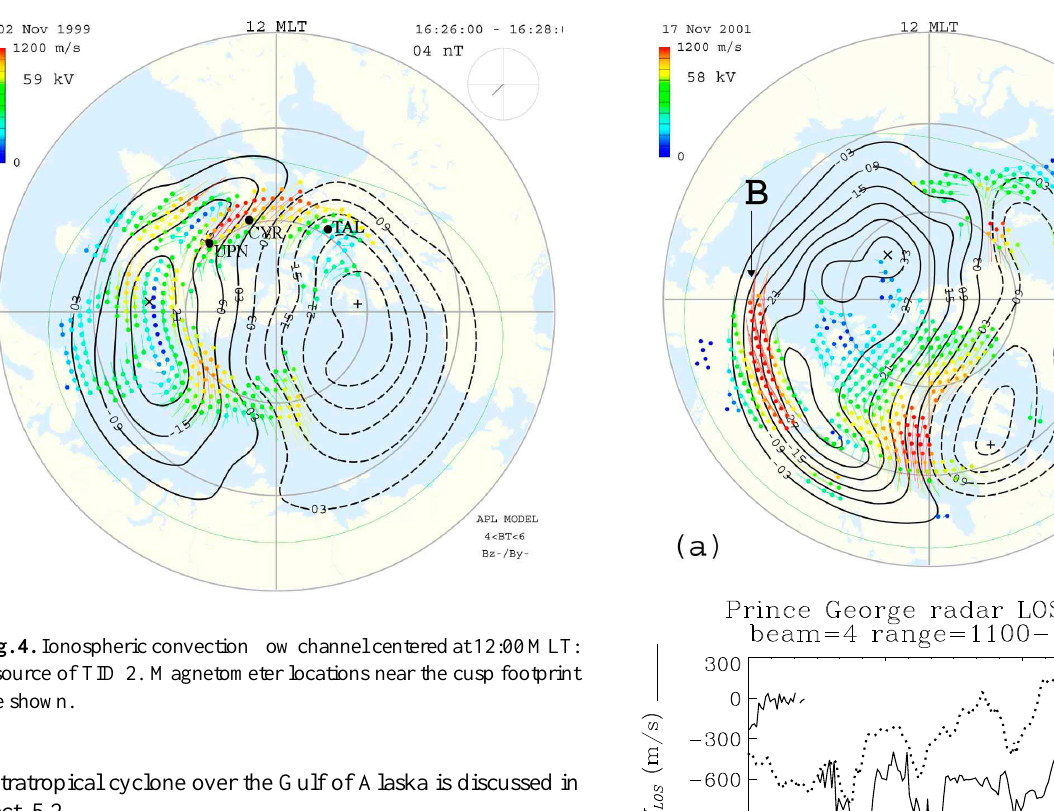
Fig. 4. Ionospheric convection flow channel centered at 12 MLT: a source of TID 2. Magnetometer locations near the cusp footprint are shown.